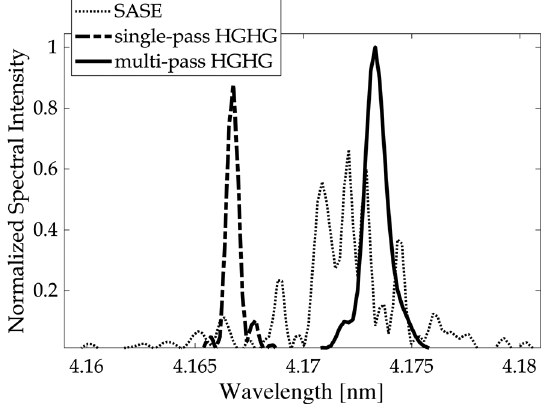
FIG. 12. All spectra for the 60 nm output radiation simulations. One can see that during the startup process, the spectral distribution shifts to longer wavelengths, where it stabilizes after about 5 roundtrips. The color represents the radiation intensity in arbitrary units. As in Fig. 10, a wavelength range of (cid:2) 3 ρ around the central wavelength of the single-pass HGHG is shown.